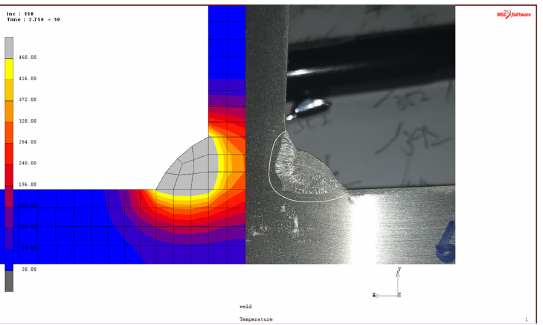
Figure 15. HAZ Verification Al 6061 T6 (macro section vs. FE analysis).